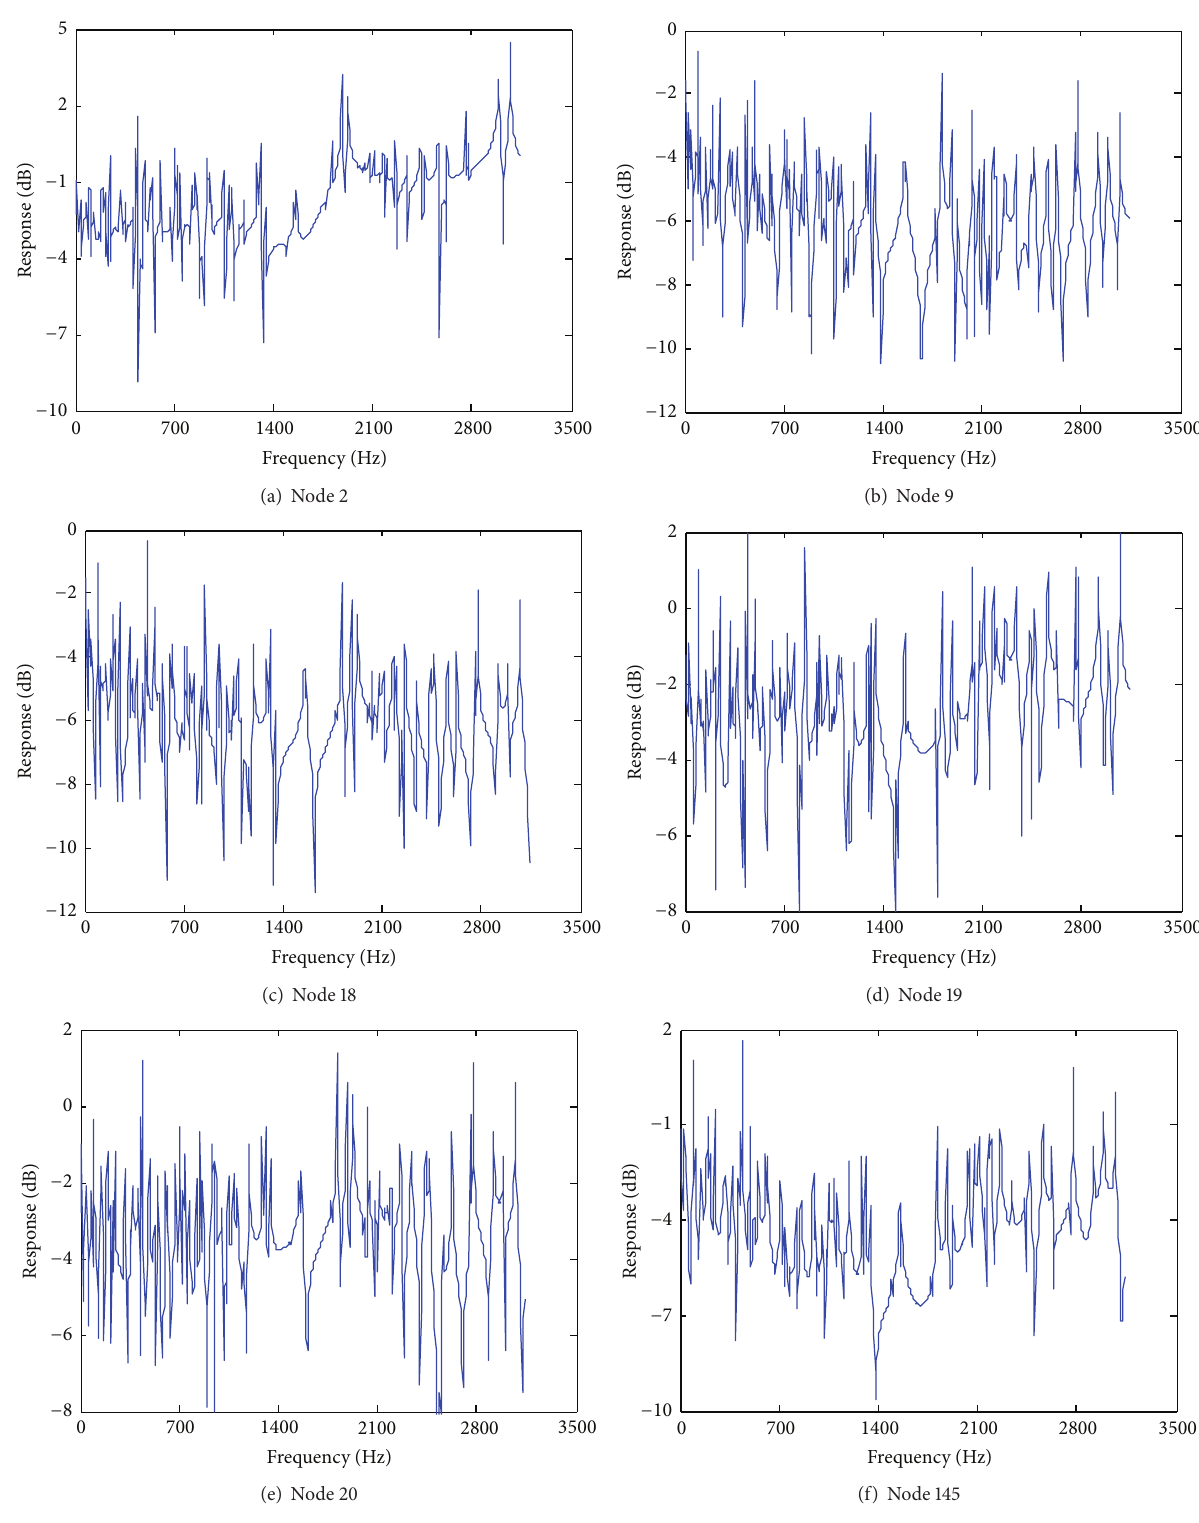
Figure 11: FRF with excitation 𝑓 applied at node